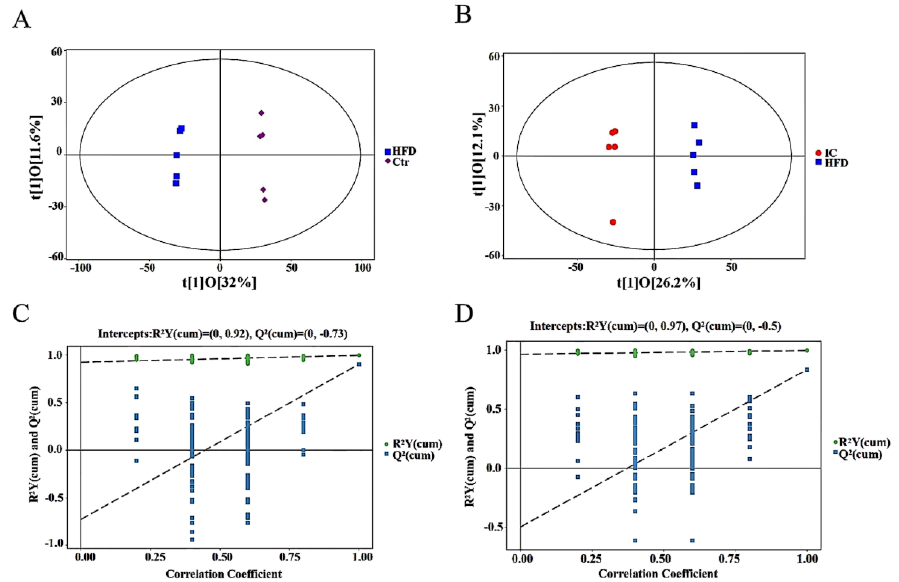
Figure 8. Overall metabolite profile differences between two groups: ( A ). OPLS-DA score scatter plot for Control and HFD groups. ( B ). OPLS-DA score scatter plot for HFD and IC groups. ( C ). OPLS-DA permutation plot for control and HFD groups. ( D ). OPLS-DA permutation plot for HFD and IC groups.